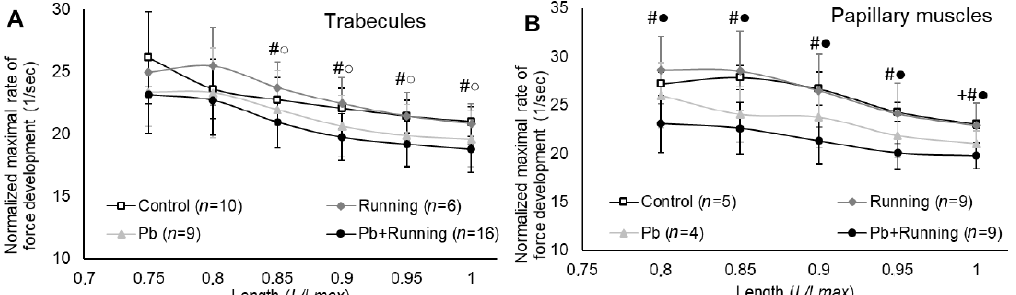
Figure 3. The relationships between active tension amplitude and relative muscle length of trabecules ( A ) and papillary muscles ( B ) in the experimental groups. The number of preparations is given in brackets. Muscle length is shown in Lmax units. Data are presented as mean ± S.D. There are significant differences (by Mann–Whitney U-test): +—“Pb” vs. “Control”.